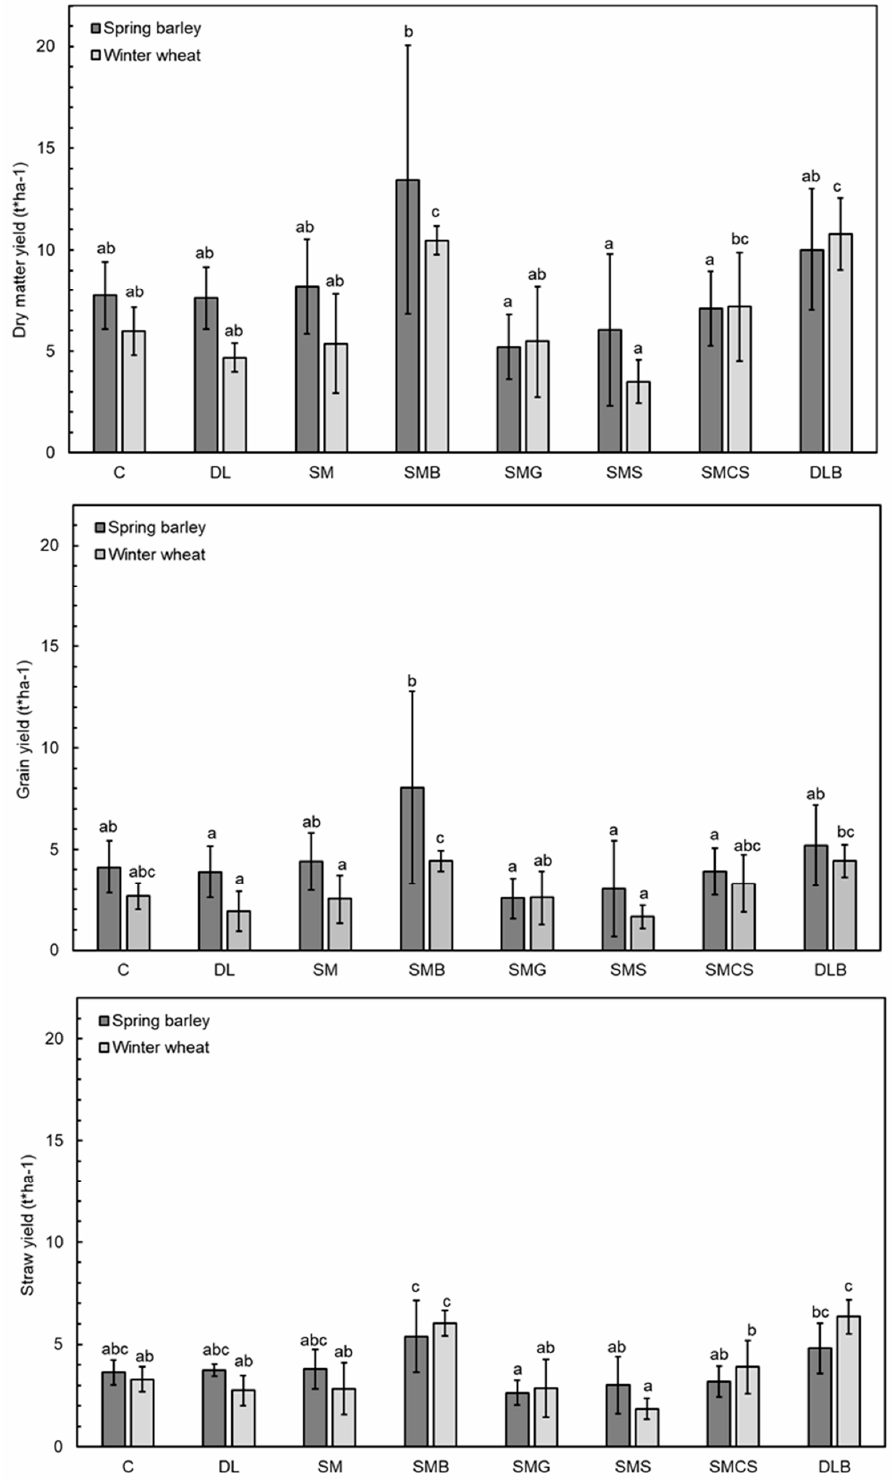
Figure 2. Dry yield, grain yield and straw yield of spring barley (2017) and winter wheat (2018). Different letters indicate significant differences between the treatments in each year ( p < 0.05, Tukey’s test), error bars represent ± SD ( n = 6). C: control, DL: deep loosening with tine, SM: spader machine, SMB: spader machine and bio compost, SMG: spader machine and green waste compost, SMS: spader machine and sawdust, SMCS: spader machine and chopped straw, DLB: deep loosening with tine and bio compost.